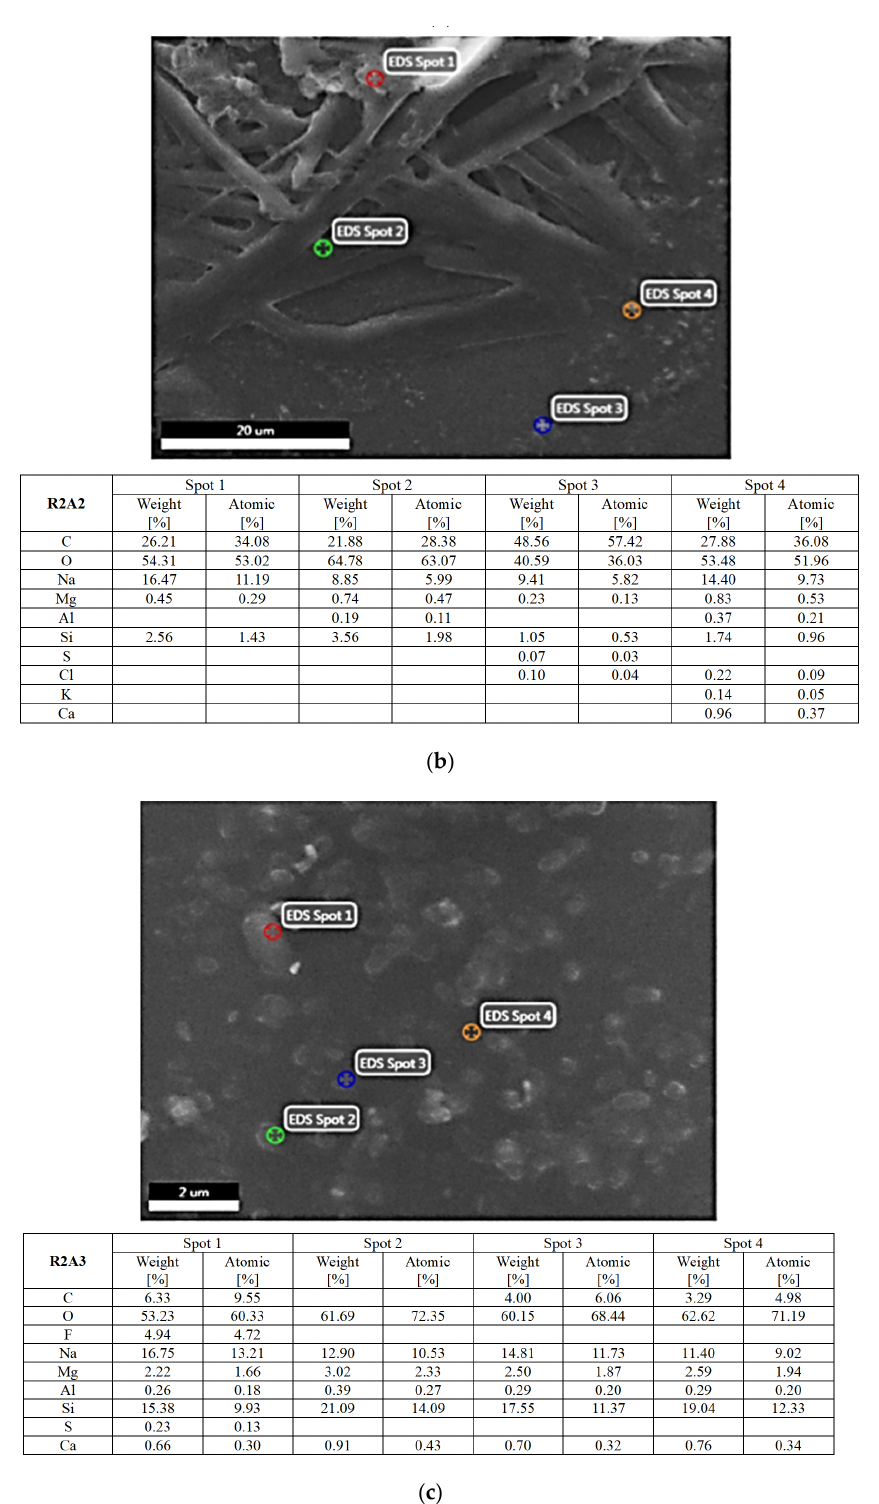
Figure 8. Report 2 of SEM-EDS results of analyzed areas of dry material decanted from rainwater: